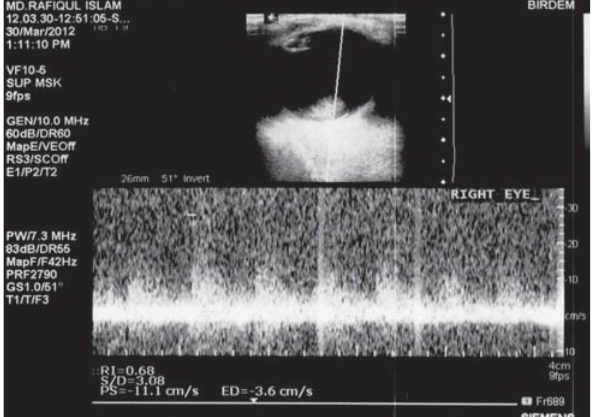
Fig 1. Spectral Doppler flow patterns of retinal artery of right eye in a normal control subject